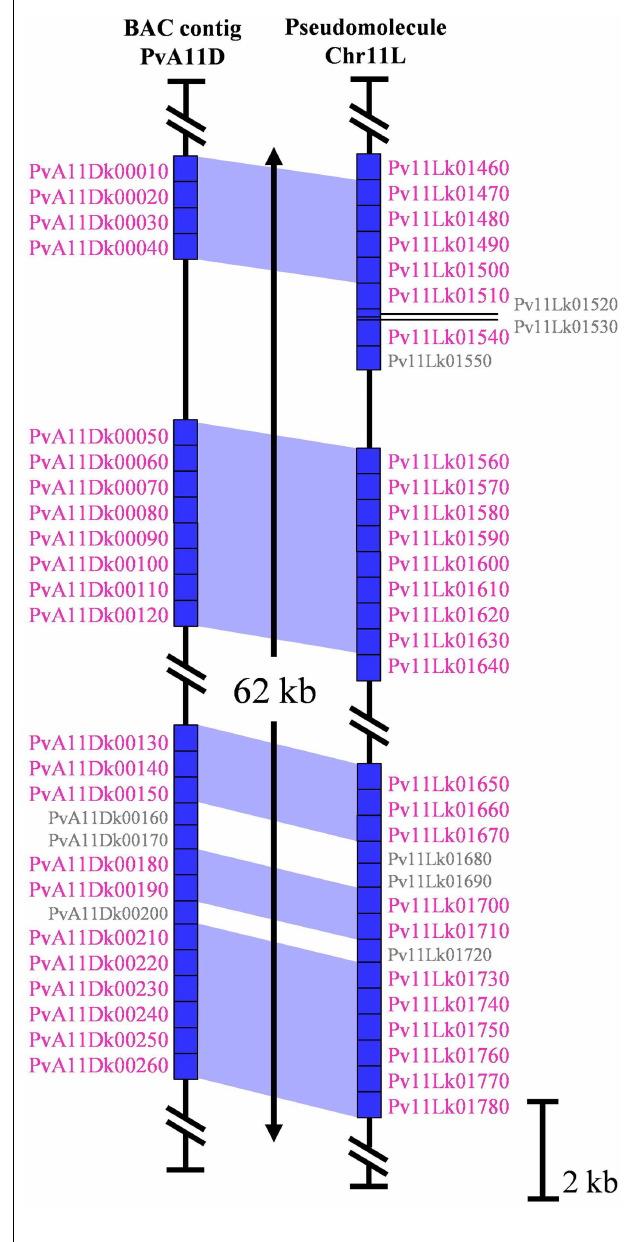
FIGURE 2 | Schematic representation of 62kb of PvA11D (200kb), containing khipu , with the corresponding region of pseudomolecule 11 . Sequences of these regions are represented by vertical black lines. Blue rectangle represent annotated khipu of the region with their name written on the side of each one. Khipu with name written in small gray correspond to khipu shorter than 500bp discarded from the analyses.The blue areas represent correspondences between khipu from BAC sequence and khipu from genome sequence according to the phylogenetic